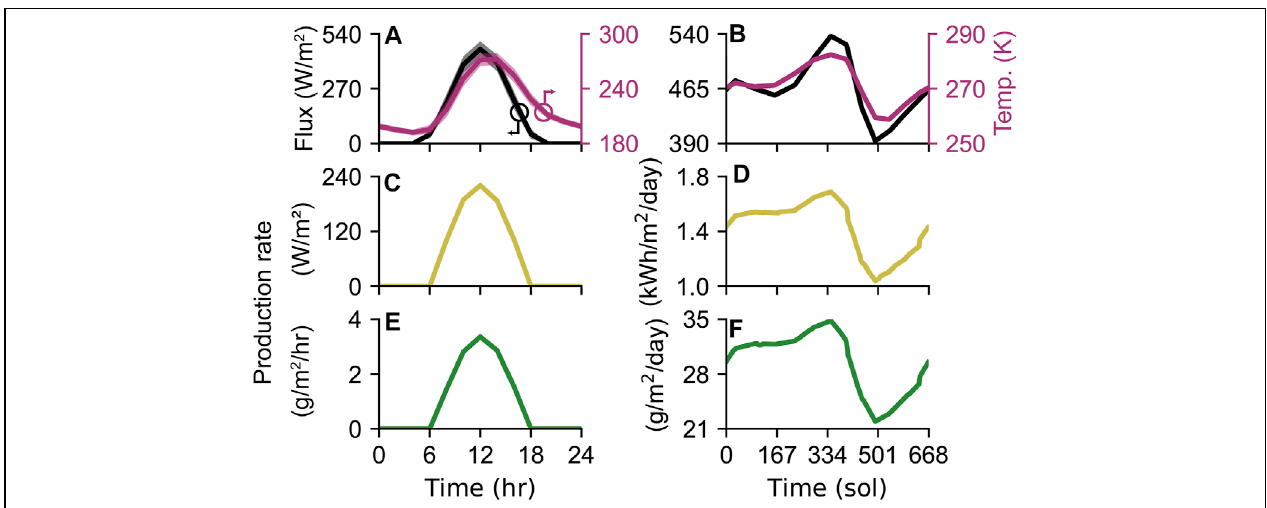
FIGURE 3 | PV and PEC production rates. (A) Average and (B) daily maximum solar flux (black, left axis) and surface temperature (purple, right axis) as function of (A) time of day and (B) time of year. (C,E) average and (D,F) daily maximum production capacity of power (C,D) and H 2 (E,F) using 3-junction PV and 2-junction PEC cells as described in the main text. Solid lines in (A,C,E) correspond to averages; shaded areas represent the standard deviation due to seasonal variation. Jezero Crater is used as the location for